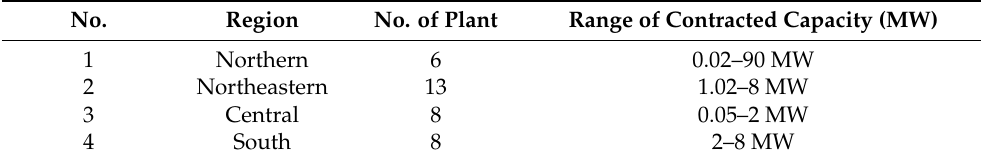
Table 1. Selected solar power plants for self-administered observation.